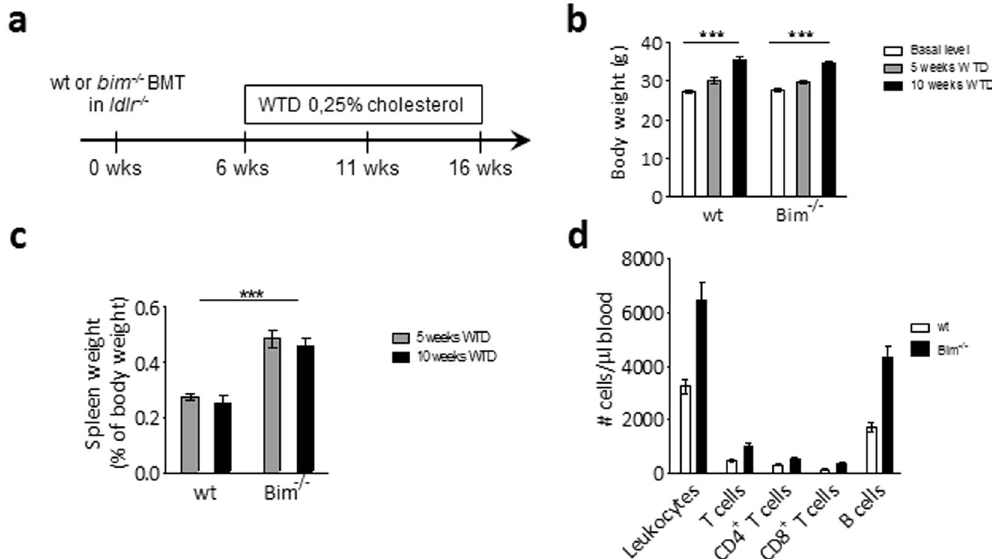
Figure 1. Bim − / − chimeric mice have splenomegaly and lymphocytosis. ( a ) Lethally irradiated ldlr − / − mice were reconstituted with wt or bim − / − bone marrow, and after 6 weeks recovery, put on a Western Type Diet containing 0.25% cholesterol for 5 (n = 7) or 10 weeks (n = 12). ( b ) Body weight of wt and bim − / − chimeric mice. Data is presented as mean ± SEM. *** p < 0.001 in two-way ANOVA. ( c ) Relative spleen weight of wt and bim − / − chimeric mice at sacrifice. Data is presented as mean ± SEM. *** p < 0.001 in two-way ANOVA. ( d ) TruCount tubes were used for quantitative analysis of leukocyte subsets in blood of wt and bim − / − chimeric mice after 5 weeks of WTD. Data is presented as mean ± SEM. p < 0.001 between wt and bim − / − groups in two- way